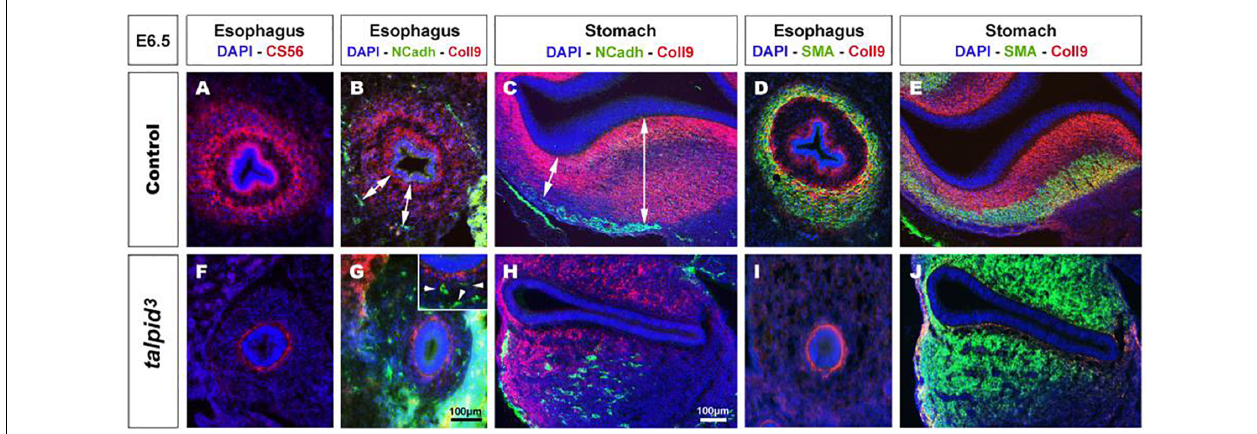
FIGURE 3 | Expression of chondroitin sulfate proteoglycans (CSPG) is altered in talpid 3 gut mesenchyme, causing the disappearance of ENCC repellent cues. (A–J) Immunofluorescent staining of esophagus and stomach with CSPG pan marker CS-56 and Coll9, in control (A–E) and talpid 3 chicken mutant (F–J) at E6.5, (B,C,G,H) co-stained with N-Cadherin and (D,E,I,J) smooth muscle actin (SMA). (A,B,D) In the esophagus, the pattern of two concentric circles of CSPG expression is lost in (F,G,I) talpid 3 mutant ( G -inset, arrowheads) coinciding with scattered ENCC. (C) In control stomach, Coll9 expression is widespread and excludes the ENS myenteric plexus whereas in ( H , double arrows) talpid 3 mutant expression is altered and loss of expression coincides with scattered ENCC. (D,E) In control, SMA expression in partially overlapping with Coll9 (yellow merge). (I,J) in talpid 3 mutants, Coll9 expression is altered and SMA is either lost (I) or extends to ectopic sub-epithelial domains (J) . Same scale bar in (A–J)